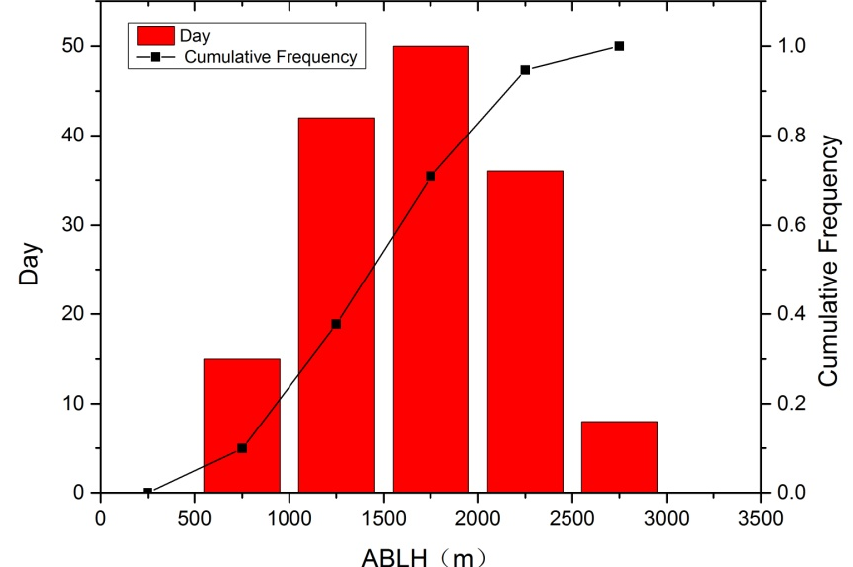
Figure 2. Cumulative probability distribution and probability distribution of the atmospheric boundary layer height (ABLH). The black line represents the cumulative frequency and the red histogram shows the number of occurrences in days.